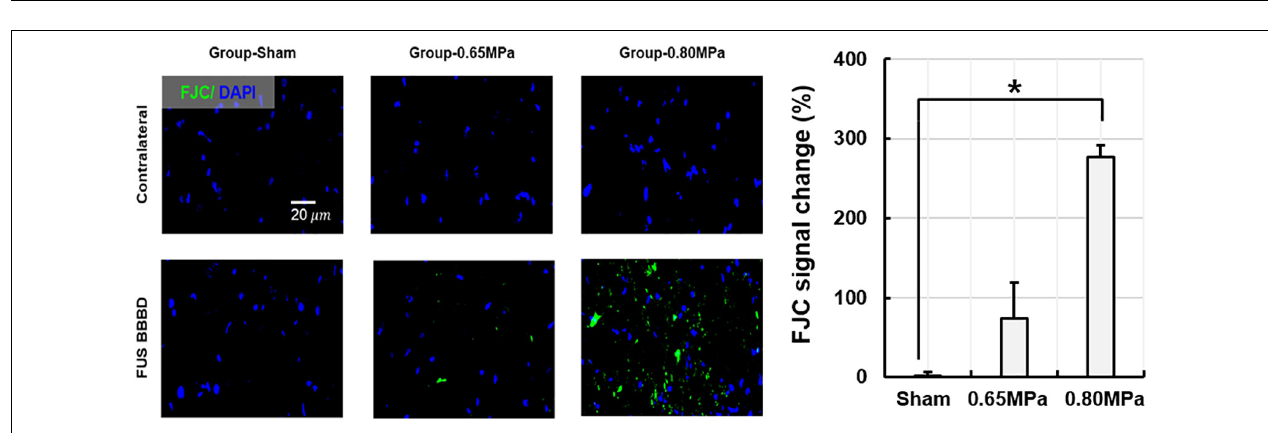
FIGURE 9 | Representative Fluoro-Jade C (FJC) histology and its quantification at 48 h after the FUS–BBBD. The samples of group-0.65 MPa show weakly expressed FJC, while those of group-0.80 MPa show notable FJC expression, indicating neuron degeneration. Green and blue fluorescence indicate the FJC expression and the DAPI, respectively. Scale bar of FJC: 20 µ m. * p <